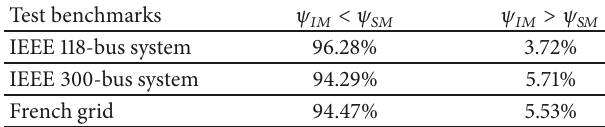
Table 4: Comparisons between the IM & SM using remaining load.